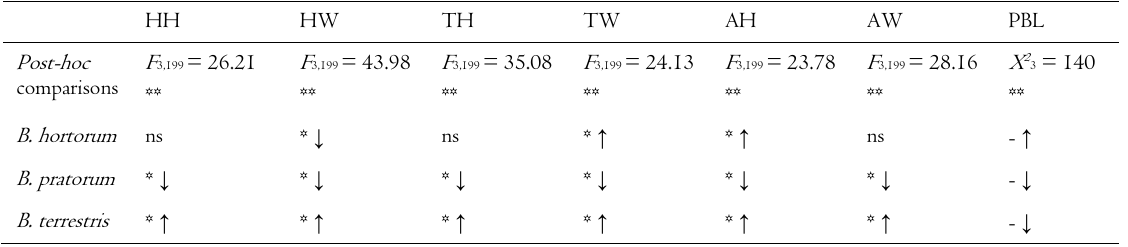
A PPENDIX 3 Morphological characteristics (for abbreviations refer to Fig. 4) compared among B. pascuorum and three bumblebee species ( B. hortorum , B. pratorum and B. terrestris ) using parametric tests (ANOVA F and Dunnett’s post-hoc test) and non-parametric tests (Mood’s